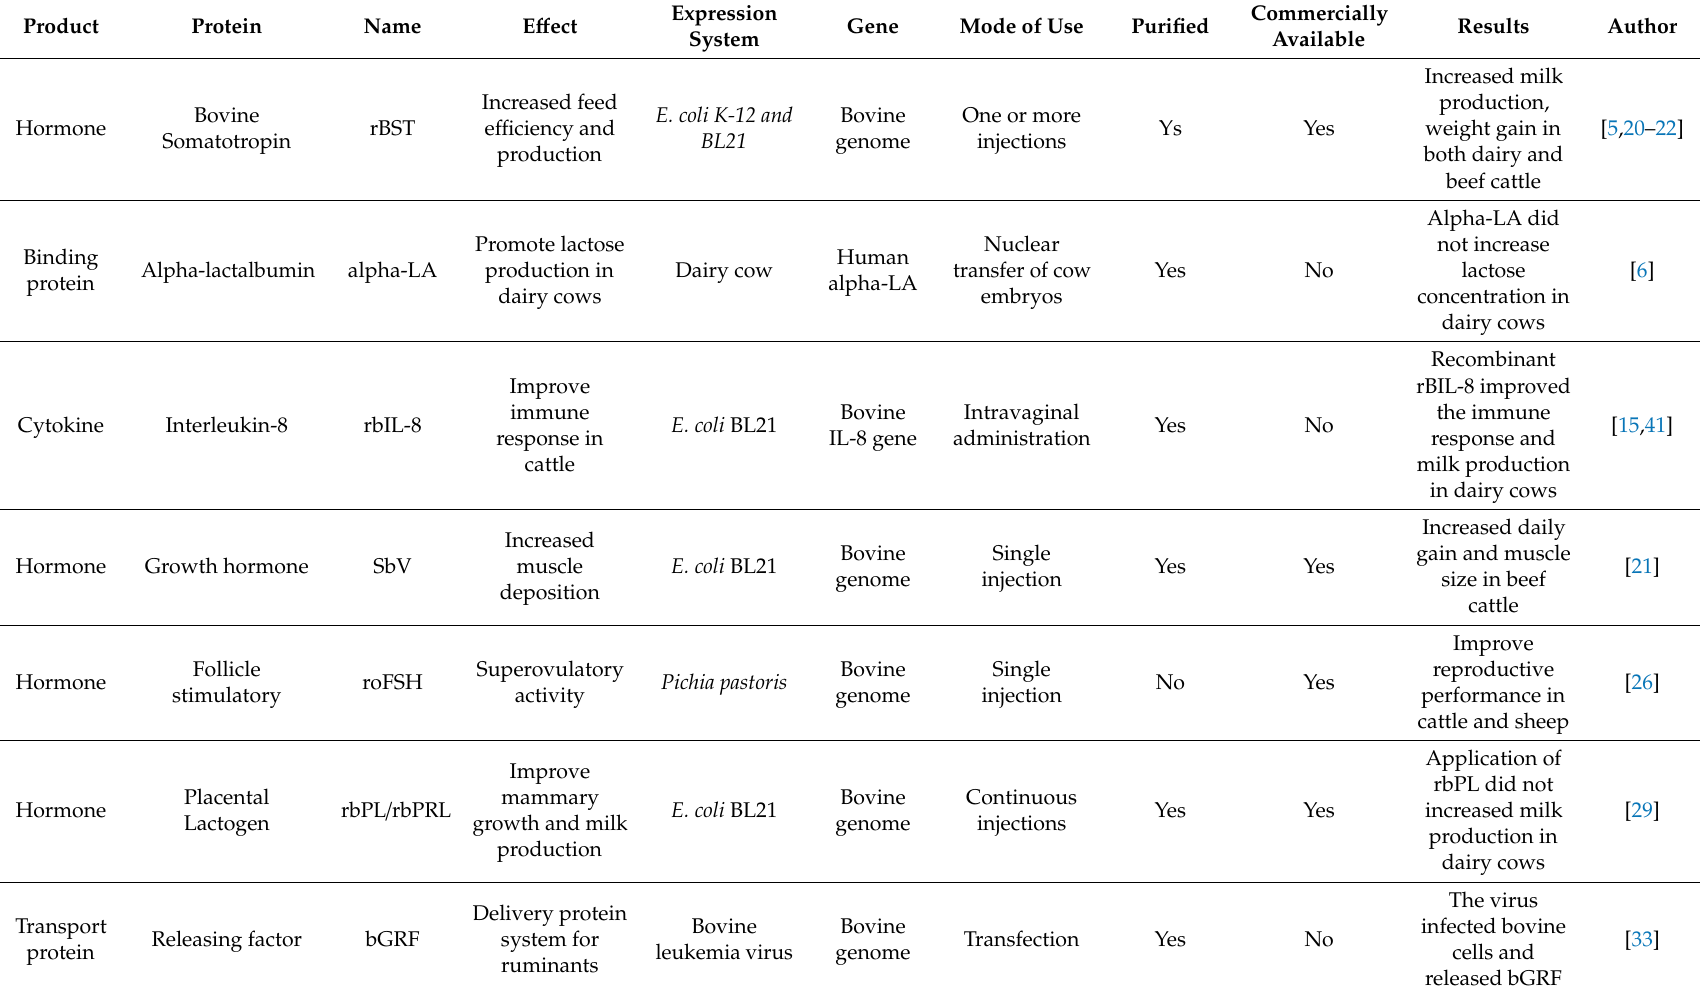
Table 1. Summary of e ff ects of recombinant hormones and immune cells on the immune status and performance of